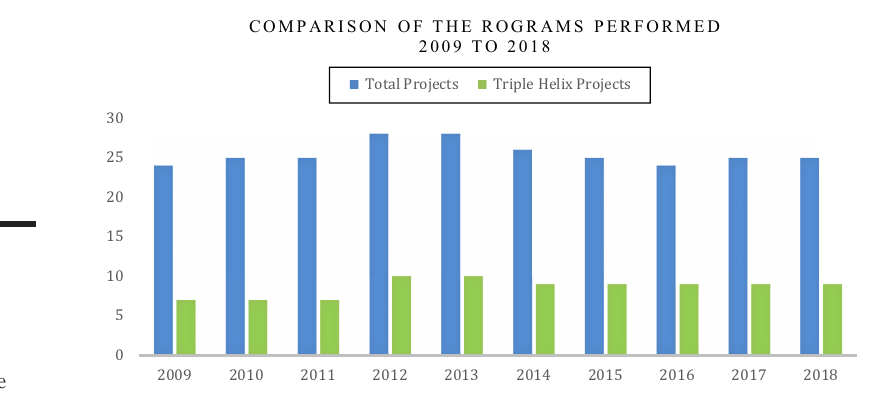
Figure 2. Comparison of accomplished programs vs triple helix